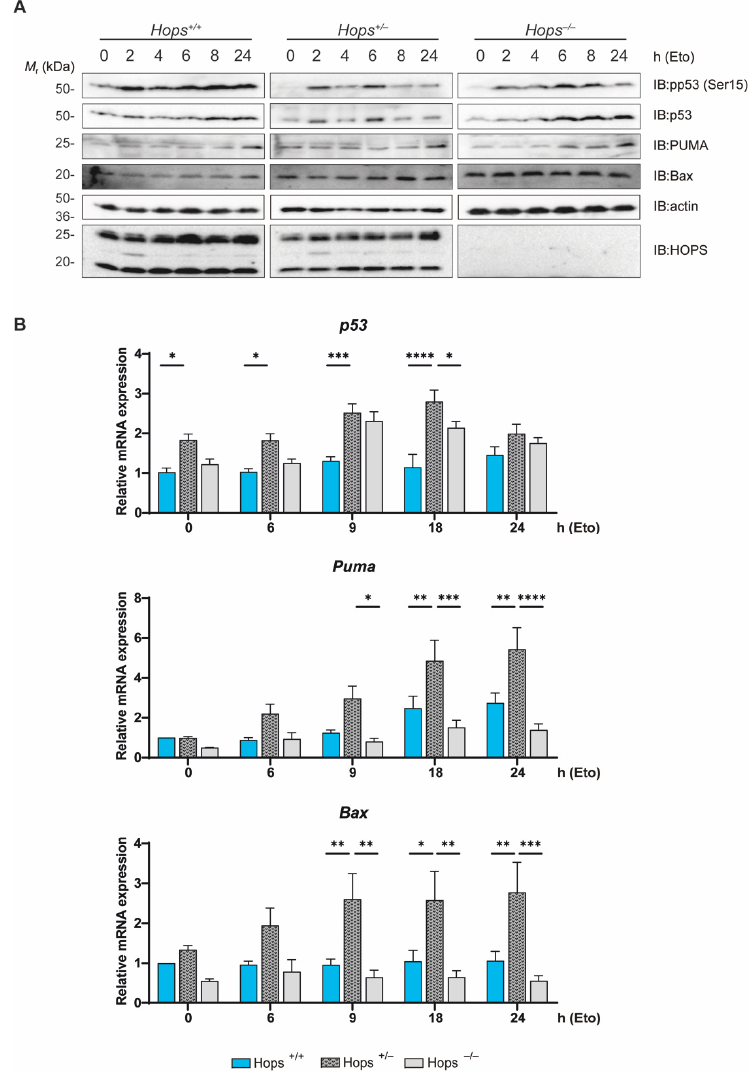
Figure 5. p53 transcriptional and non-transcriptional activation upon etoposide treatment. ( A ) Western blot analysis in Hops +/+ , Hops +/ − , and Hops − / − MEFs of p53 tumor-suppressor protein amount, phos- phorylation at Ser15 (p-p53 (Ser15)), Bax, and PUMA, following treatment at the indicated times. β - actin antibody was used as the loading control. The experiment was performed three times and representative panels are shown. ( B ) p53, PUMA, and BAX mRNA levels were analyzed by RT-PCR in cells treated as in A. The p -values were calculated by two-way ANOVA followed by Tukey's multiple-comparisons test. * p < 0.05, ** p < 0.01, *** p < 0.001, and **** p < 0.0001.